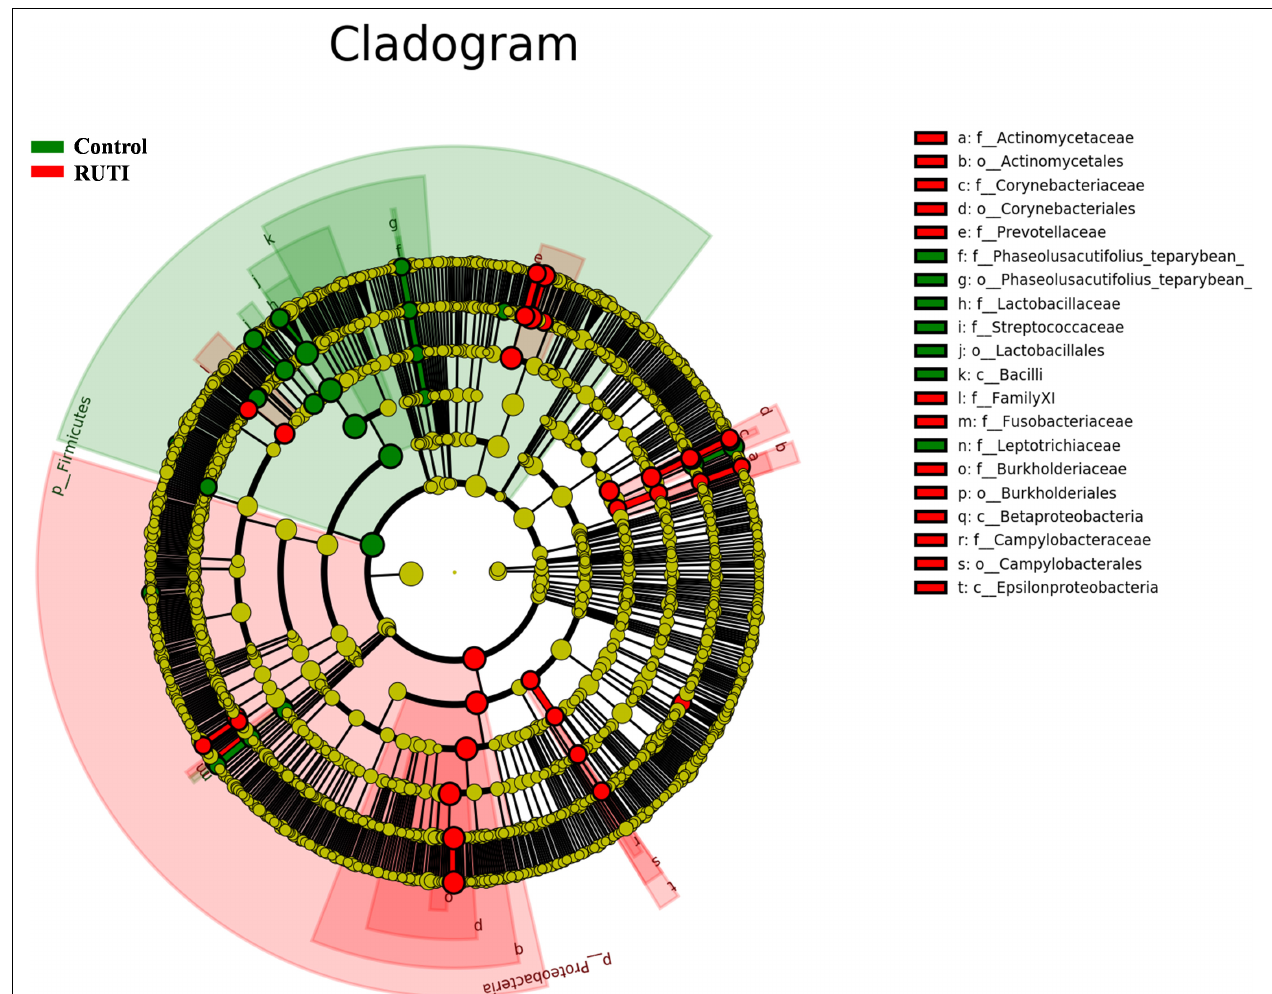
FIGURE 6 | Cladogram representation of differentially abundant taxonomic clades with LDA score > 3.0 in RUTI and controls. In cladogram, the circles radiating from inside out represented taxonomic levels from phylum to genus. Each small circle represented a classification at different levels. The diameter of small circles was proportional to its relative abundance. Those classifications with no significant difference were marked yellow. Red and green represented RUTI and control groups.